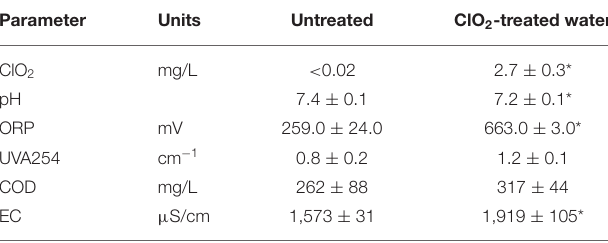
TABLE 1 | Mean ± standard deviation of the different water physicochemical parameters measured in untreated (2nd test of recirculated water without ClO 2 treatment; n = 10) and ClO 2 -treated water (3rd test of recirculated water with ClO 2 treatment; n = 10).